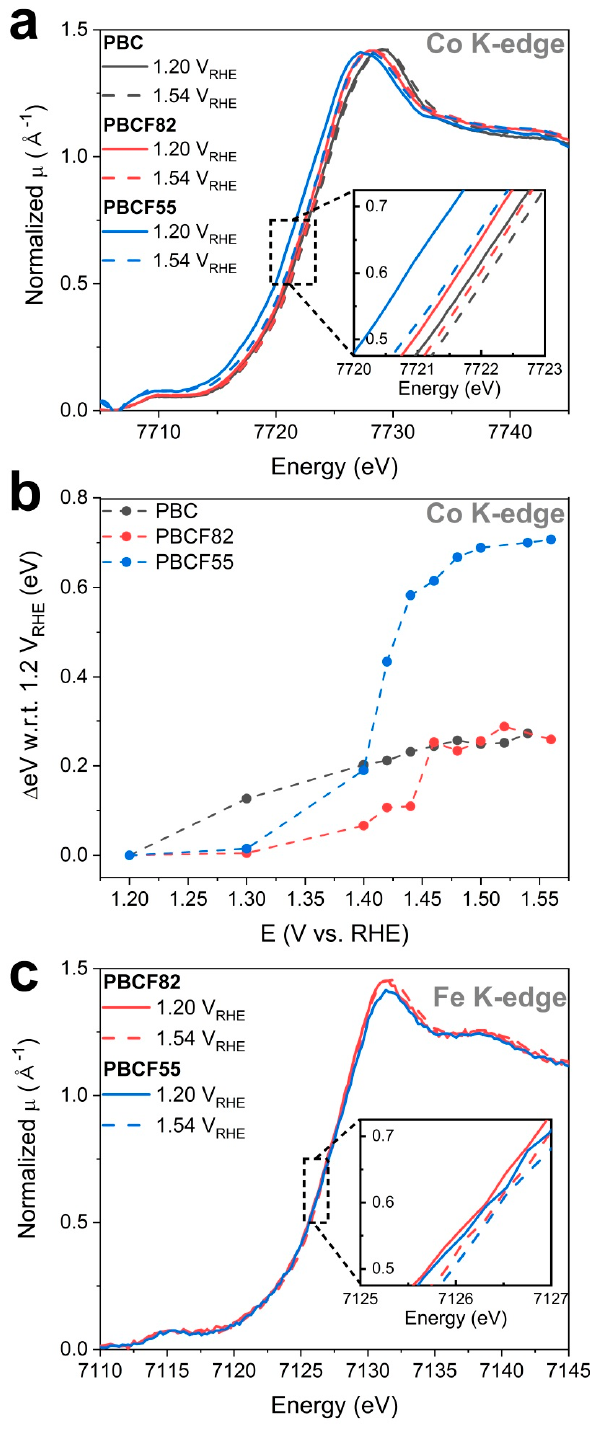
Figure 5. ( a ) comparison of Co K-edge XANES spectra of PBC, PBCF82, and PBCF55 recorded at 1.2 and 1.54 V RHE ; and ( b ) Co K-edge energy shift measured with respect to the edge position at 1.2 V RHE at each potential during operando flow cell tests; ( c ) comparison of Fe K-edge XANES spectra of PBCF82 and PBCF55 recorded at 1.2 and 1.54 V RHE .